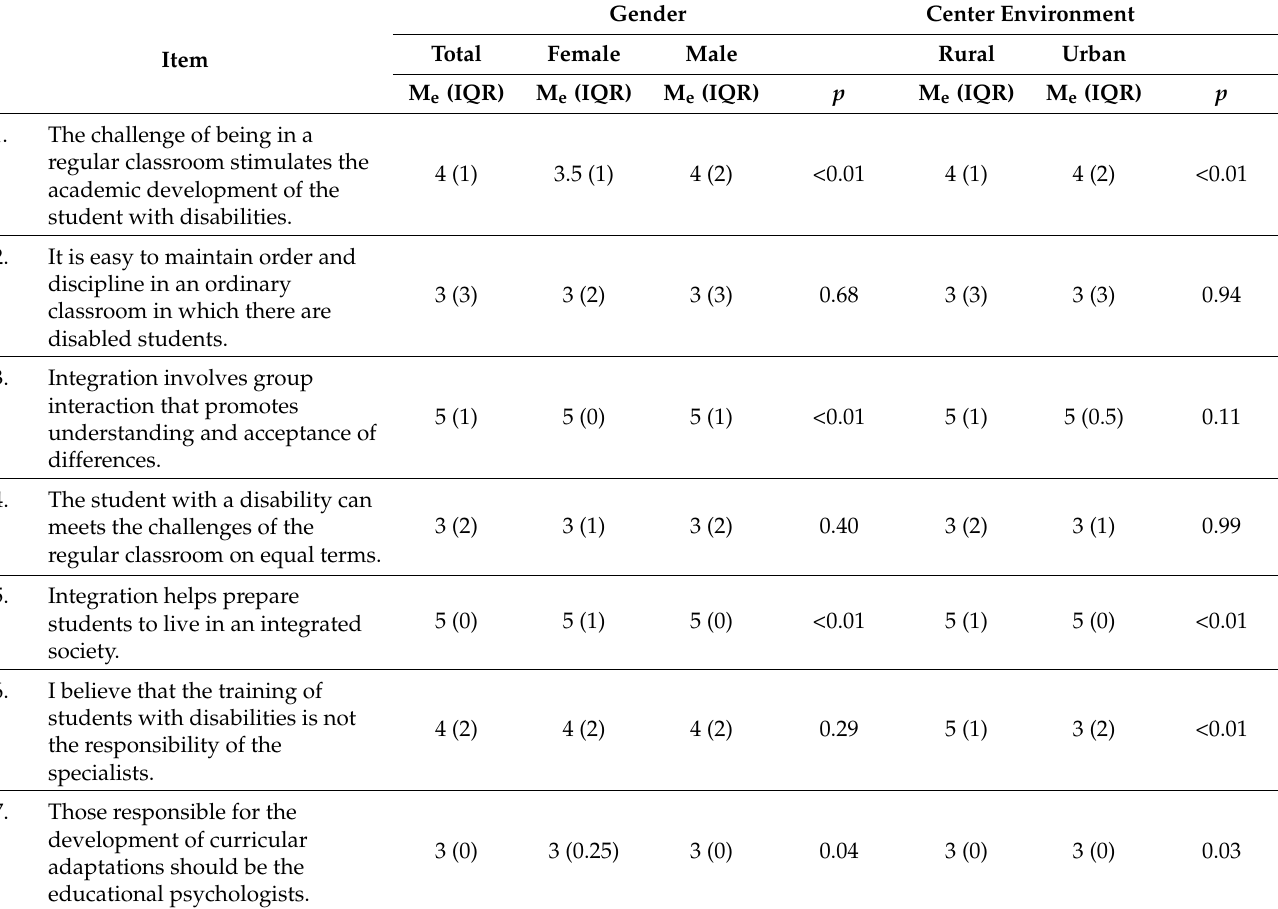
Table 2. Descriptive analysis and differences by sex and center location of the questionnaire